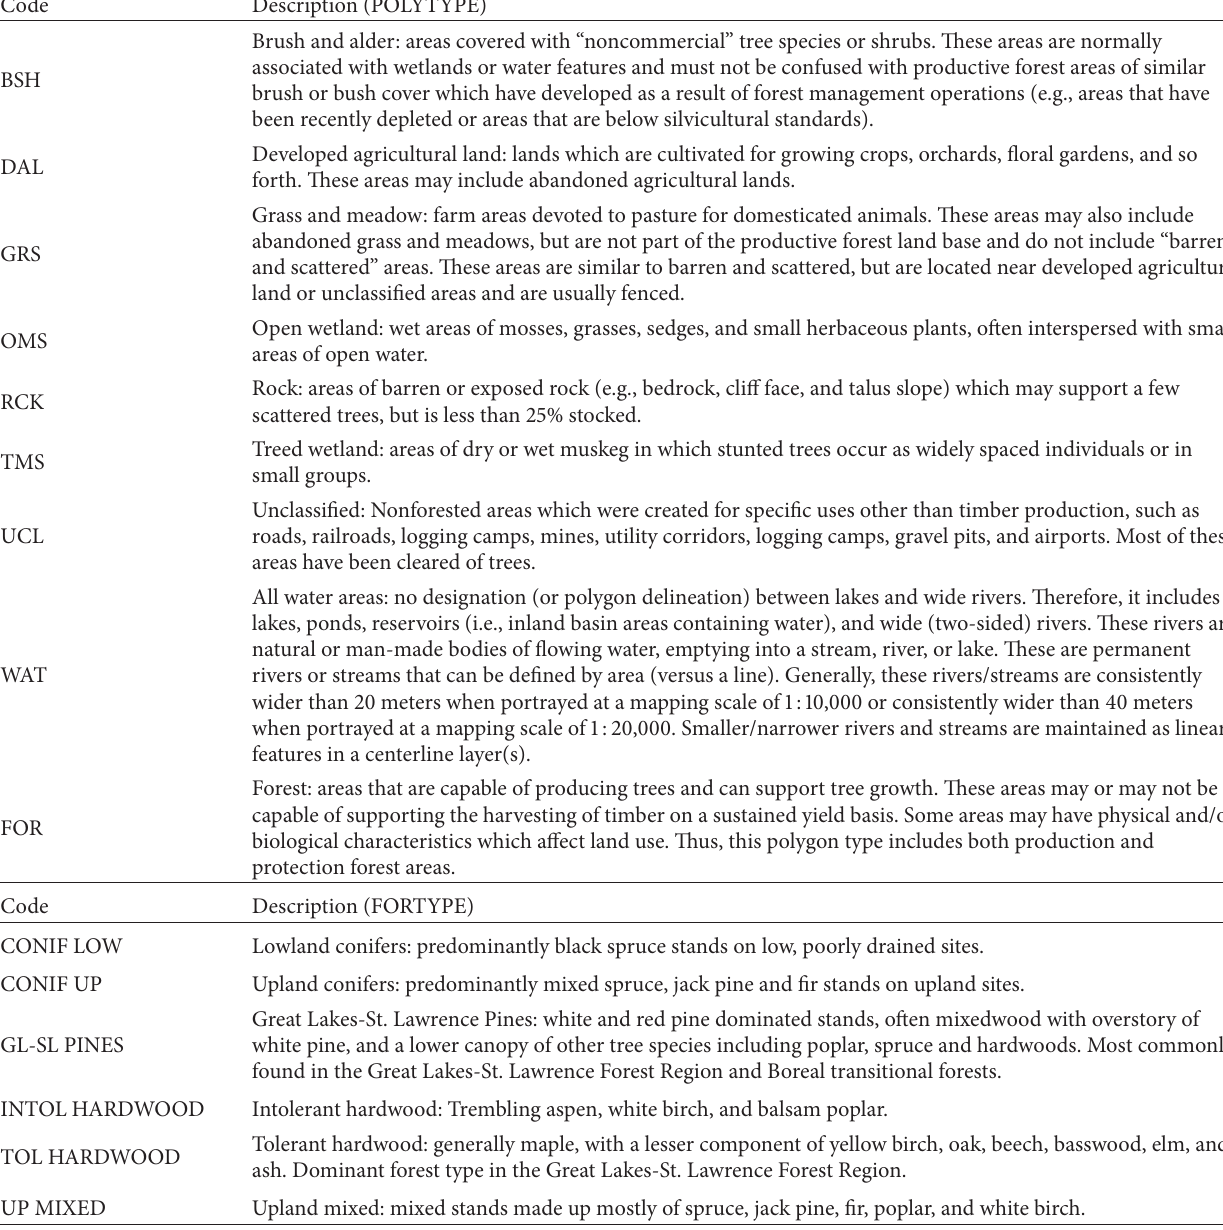
Table 2: Description of habitat types used in habitat utilisation analyses (Forest Information Manual 2007, Ministry of Natural Resources). Code Description